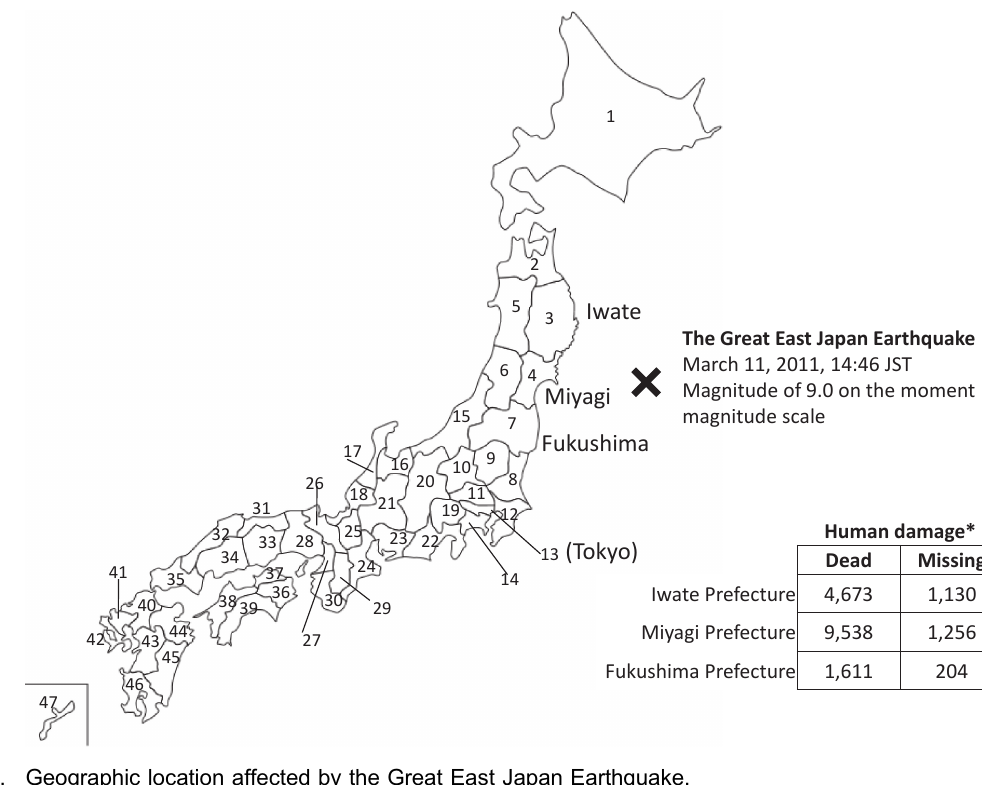
Figure 1. Geographic location affected by the Great East Japan Earthquake. The numbers on the map indicate prefecture codes corresponding to those in Table 1, Table 2, and Table 4. * The human damage number shows dead and missing persons in Iwate, Miyagi, and Fukushima Prefectures that were the most seriously affected by the Great East Japan Earthquake (The numbers are cited from Japan Meteorological Agency and National Police